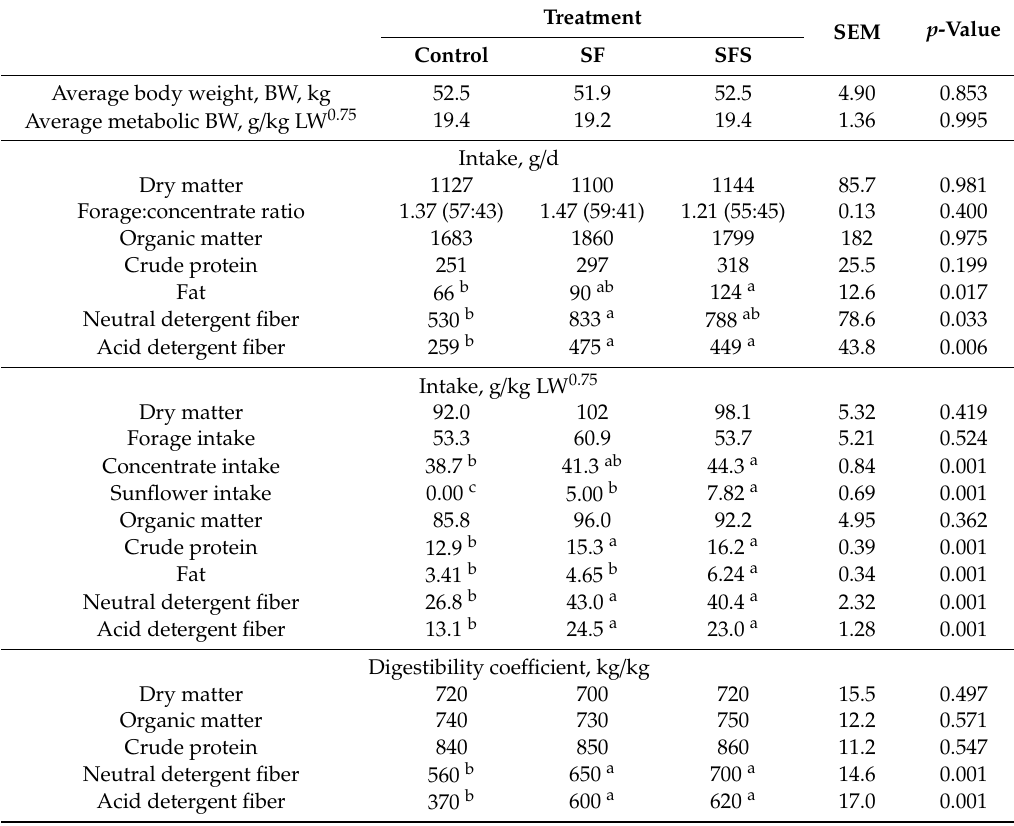
Table 3. Intake (g / d, g / kg LW 0.75 ) and digestibility coe ffi cients (kg / kg) in dairy sheep fed control, sunflower seeds (SF), and sunflower seeds silage (SFS) treatments.